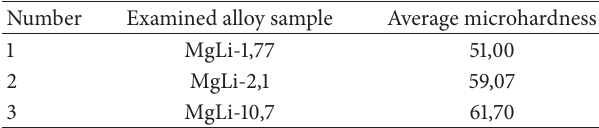
Table 1: Values of Vickers microhardness test measurements